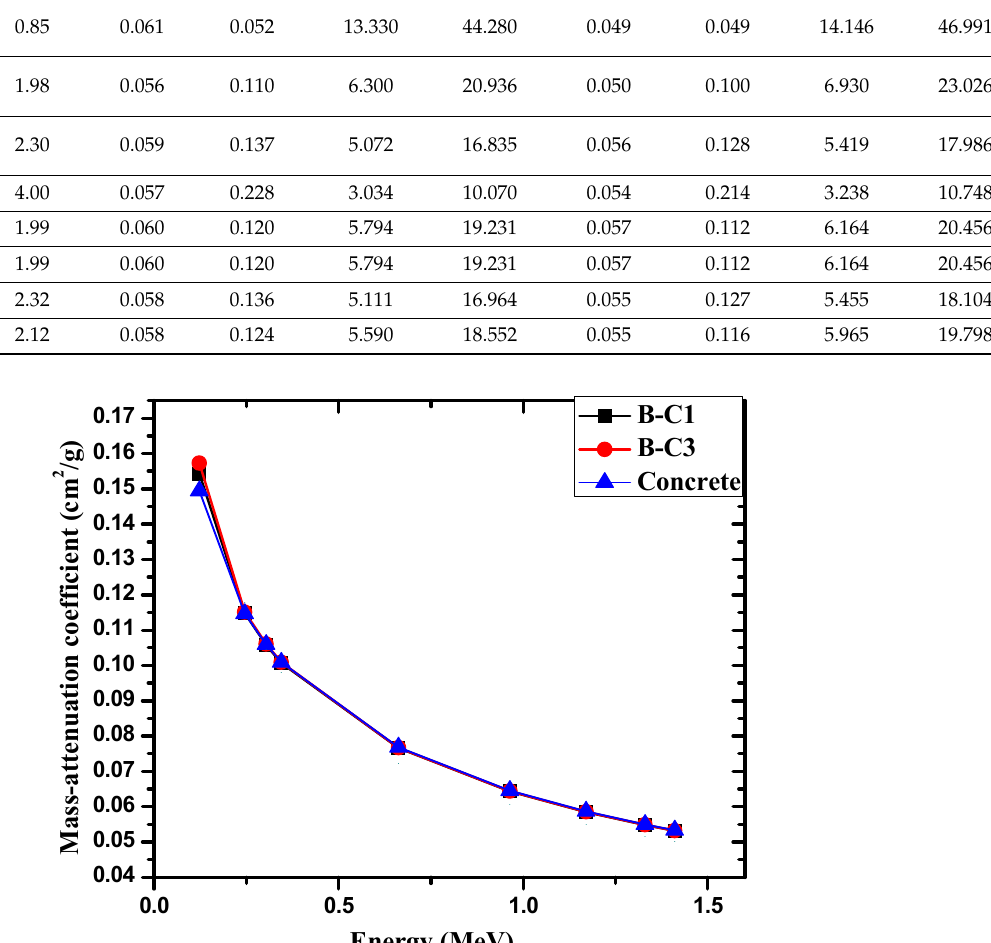
Figure 5. The compared mass attenuation coefficient of the studied shielded samples with iron at different energies.